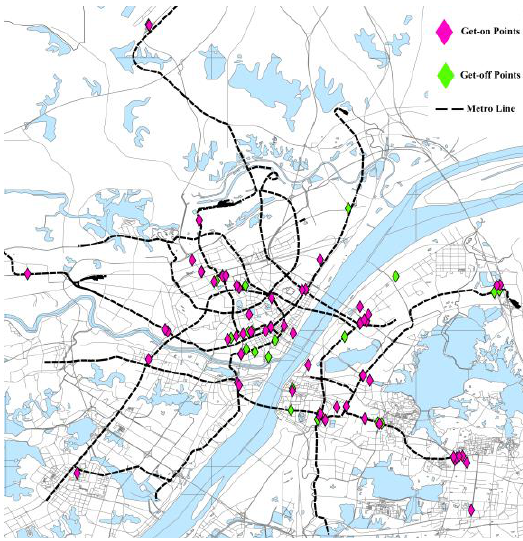
Figure 6. Spatial distribution of the level 4 and 5 docking points. Since the high-level docking points can best reflect the hotspots, we focus on level 4 and 5 docking points. The docking point distributions on the weekdays and weekends are respectively shown in Figure 7. We find that the pick-up and drop-off docking points are almost the same on the weekdays and the weekends, which are dominated by transportation hub ports and commercial districts at the city center. However, on the weekends, there are several new docking points (red circle in Figure 7). These places are ① Okuyama Century Plaza,